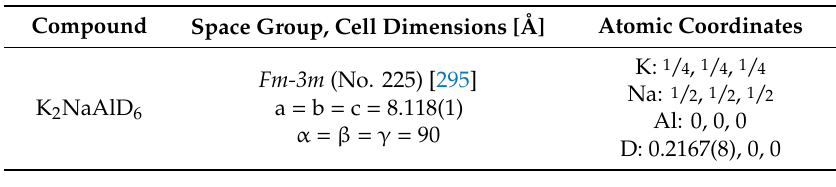
Table 18. Crystallographic data of Na-K mixed alanates.